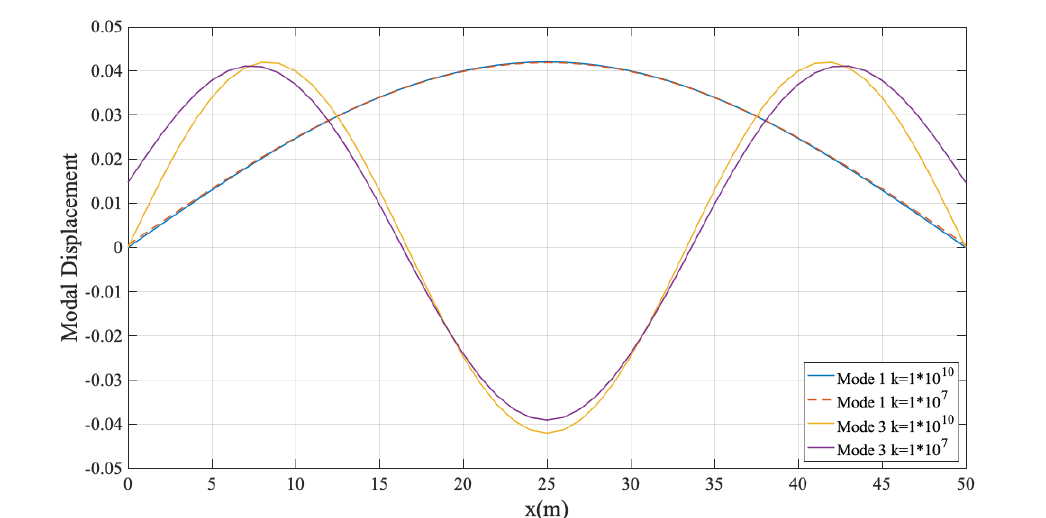
Figure 10. Mode shapes of the bridge with different bearing stiffness values.